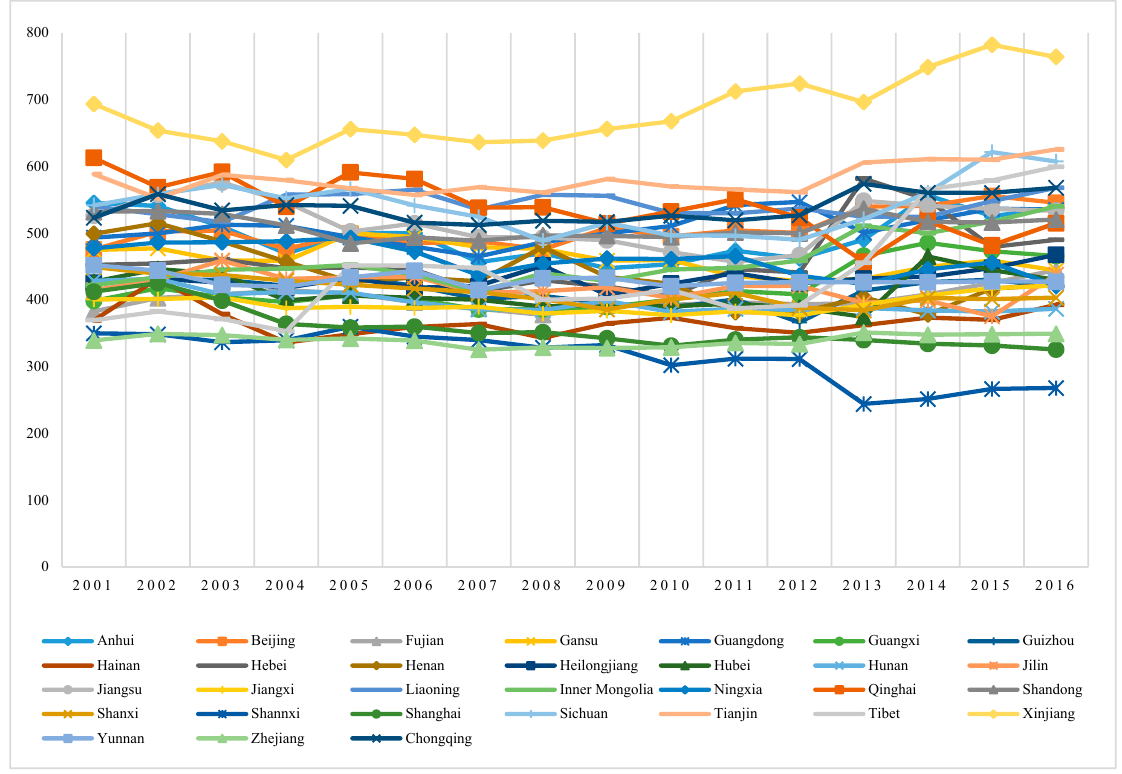
Figure 3. Per capita water footprint of food consumption in each province (m 3 /year).